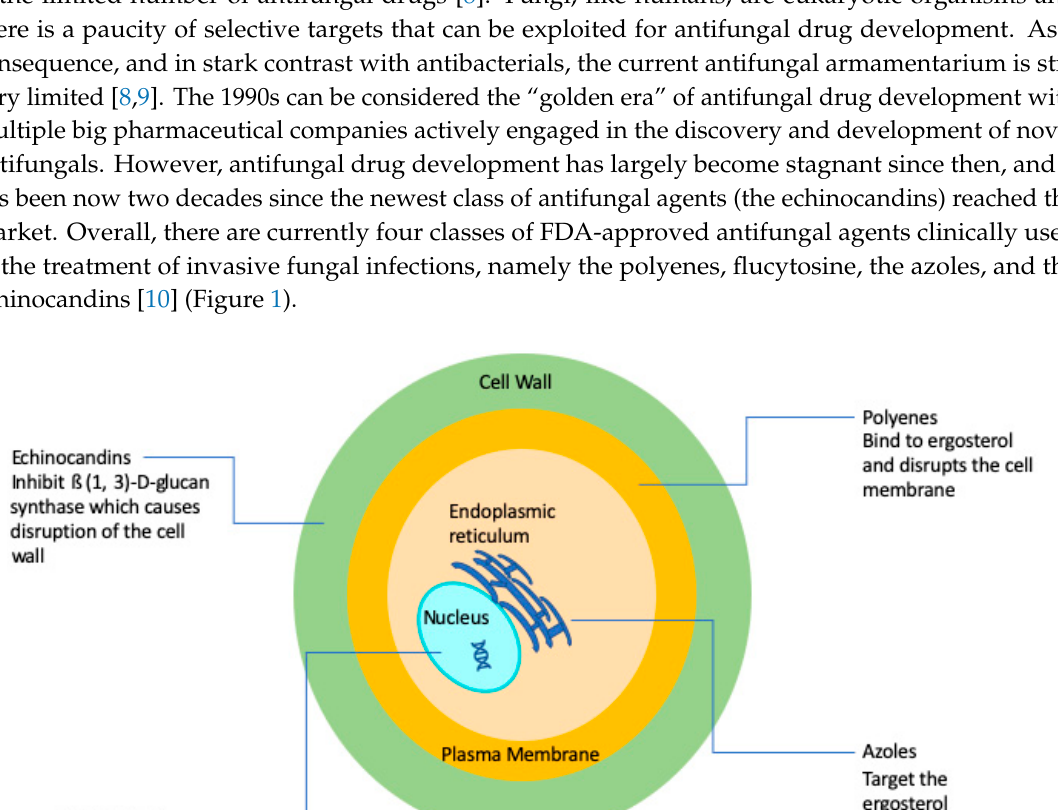
Figure 1. Simplified schematic diagram depicting the current antifungals and their modes of action.